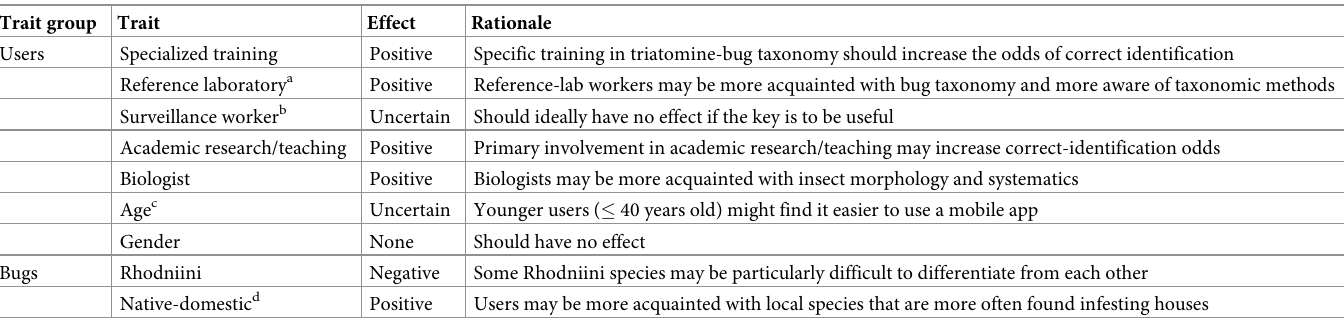
Table 3. Hypotheses about sources of variation in T RIATO D EX performance. Trait group